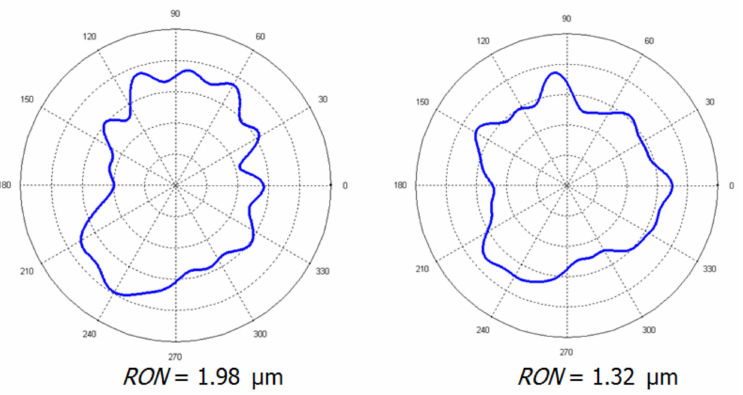
Figure 10. The profiles used for the air gauge positioning precision